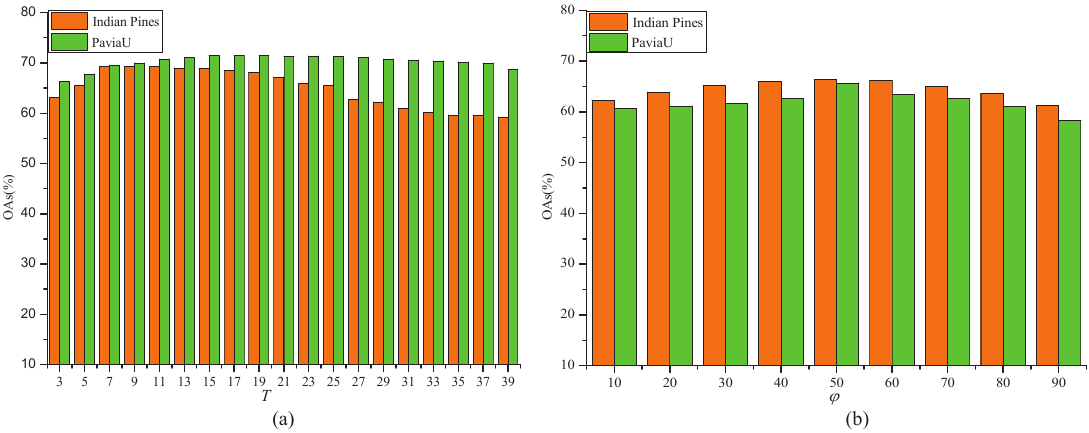
Figure 8. OAs with respect to parameters T and ϕ on different datasets: ( a ) the OAs of T ; and ( b ) the OAs of ϕ